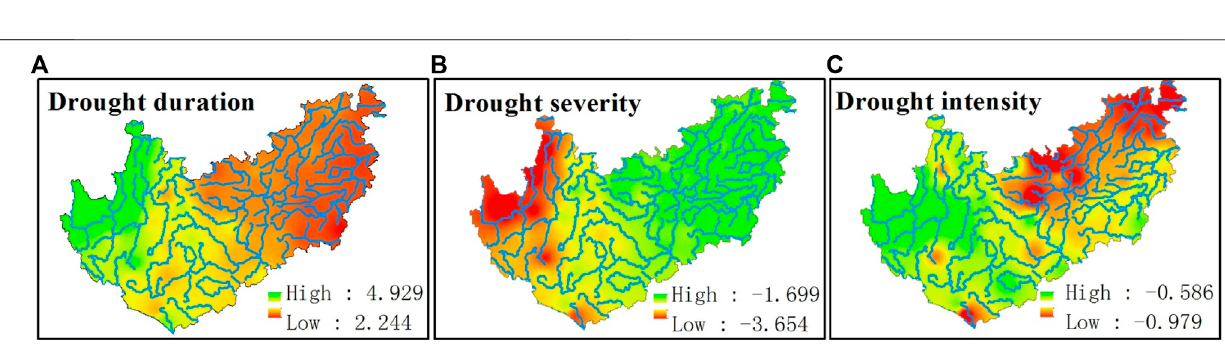
FIGURE 8 | The spatial distribution of the fi rst two components of SPEI in annual and each season. The fi rst component of the SPEI was obtained by multiplying PC1 by the corresponding time coef fi cient and then taking the average. The second component of the SPEI was calculated by the same method.